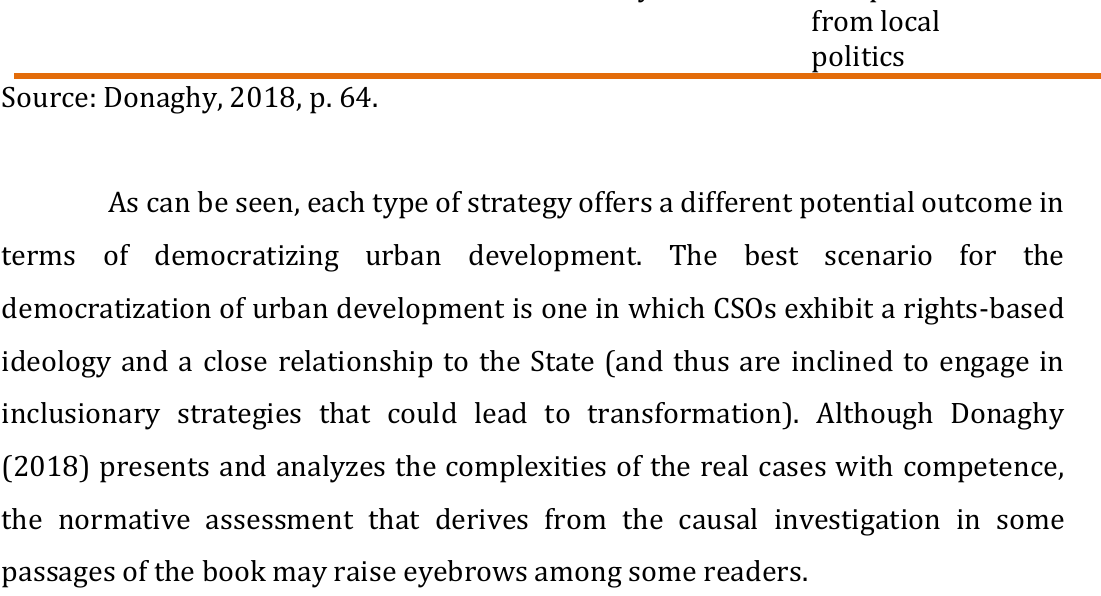
Table 02. Types of strategies: impact on outcomes Type of Instrumental goals Outcome for strategy Inclusionary Structural change, direct decision making Indirect Additional resources, implementation of programs Overhaul Allies in power Political change Exit Outside influence, autonomy Independence